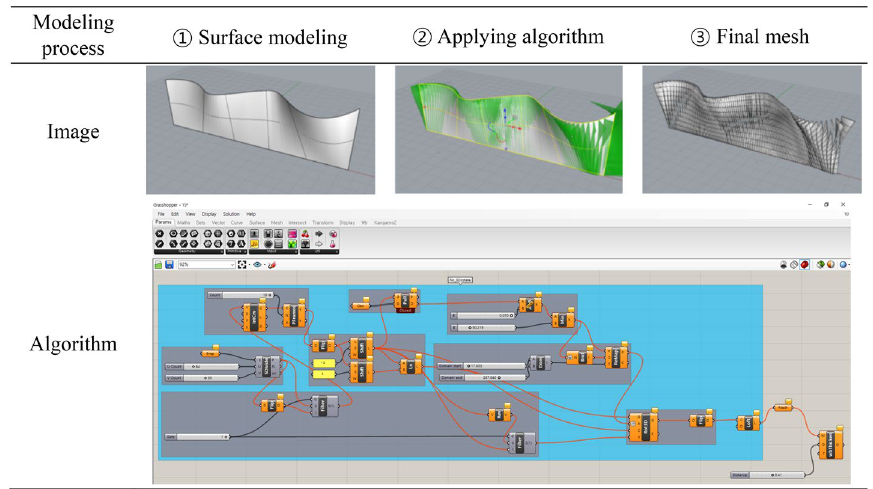
Table 2 Modeling process of ‘Motif 1’